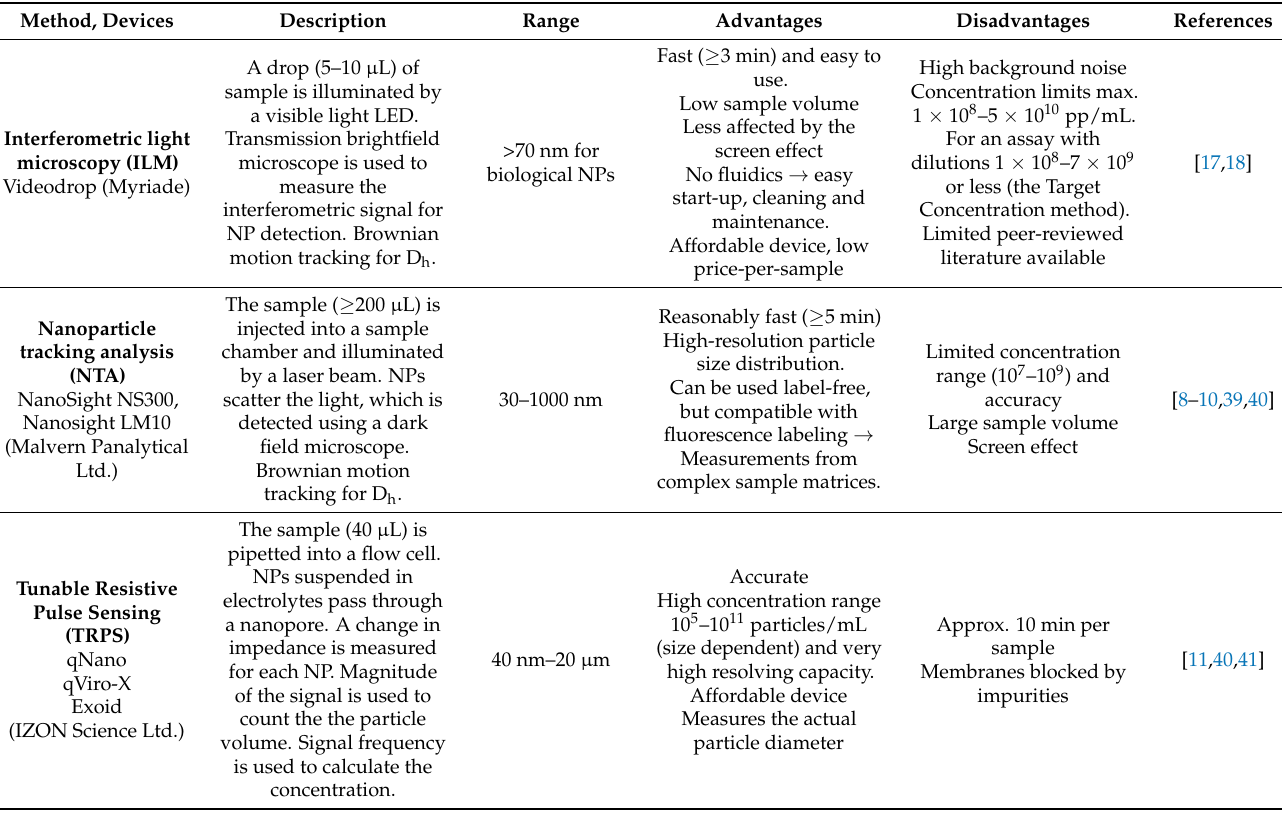
Table 3. Comparison of commercially available devices for total nanoparticle counting with rapid time to results. Method, Devices